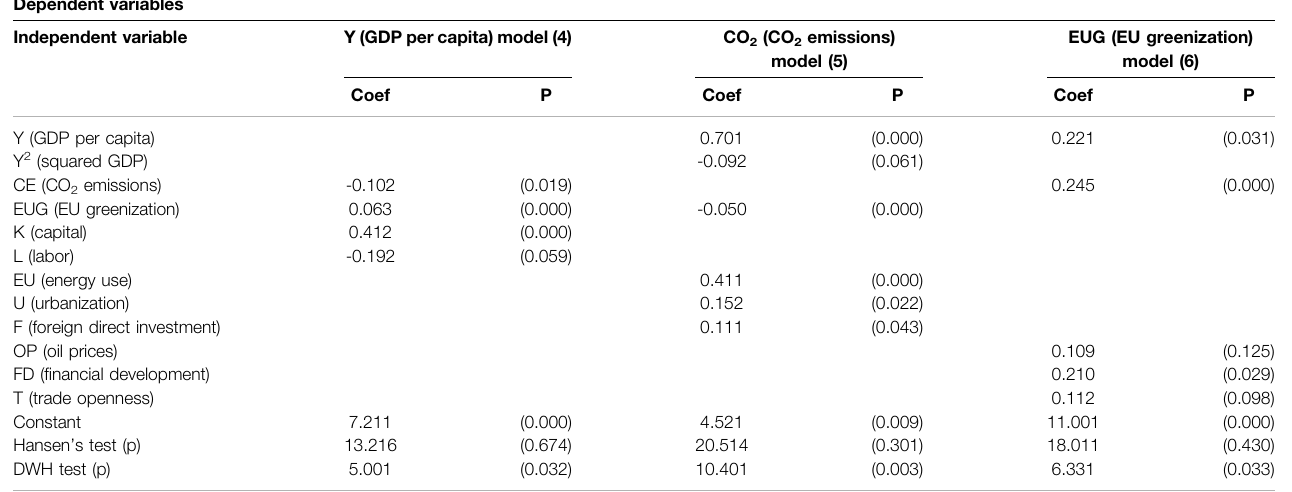
TABLE 3 | Simultaneous equation generalized method of moment estimation for the models. Dependent